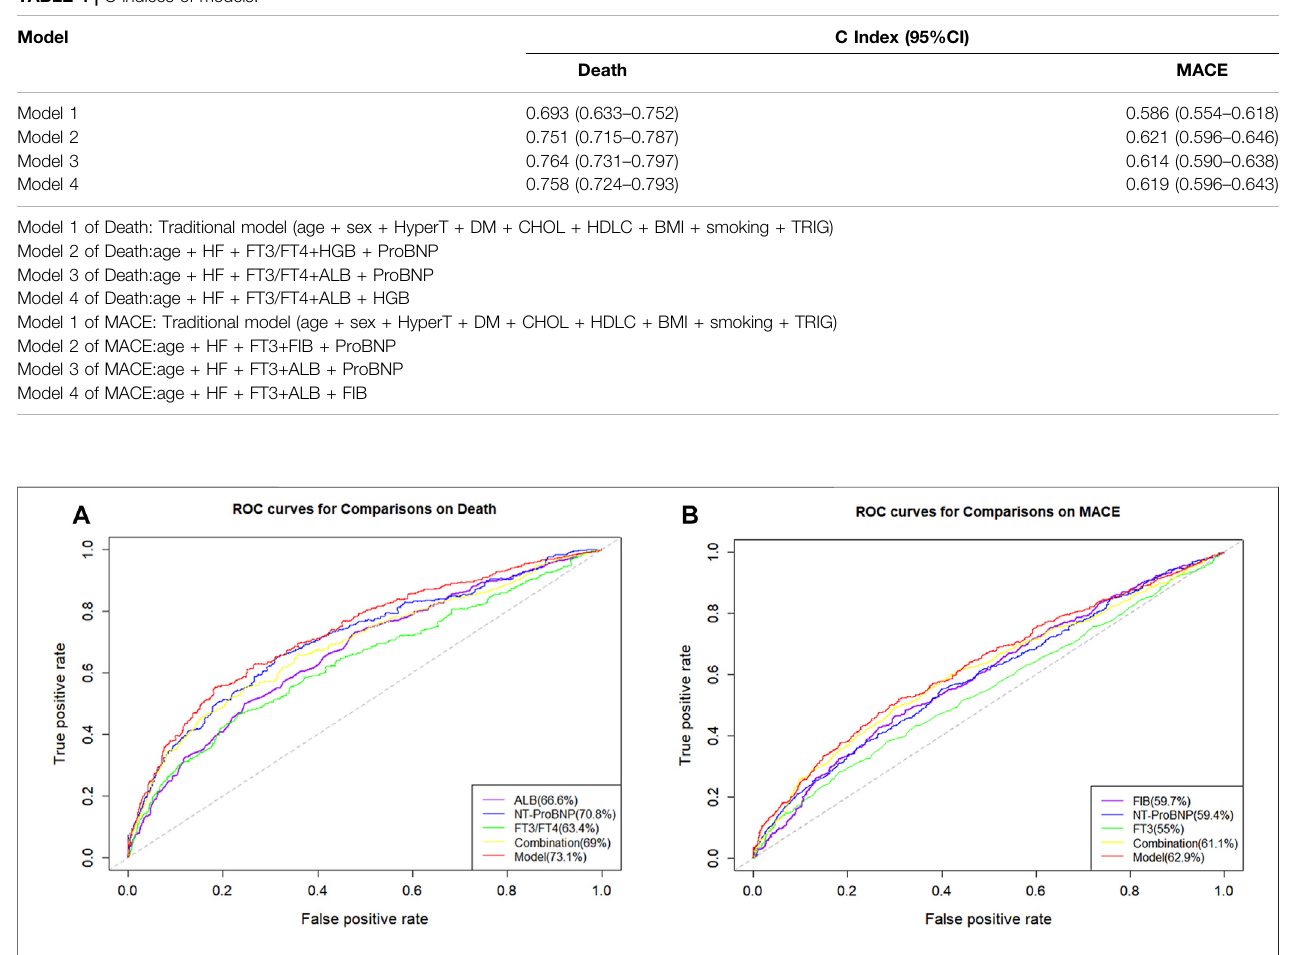
TABLE 4 | C indices of models.